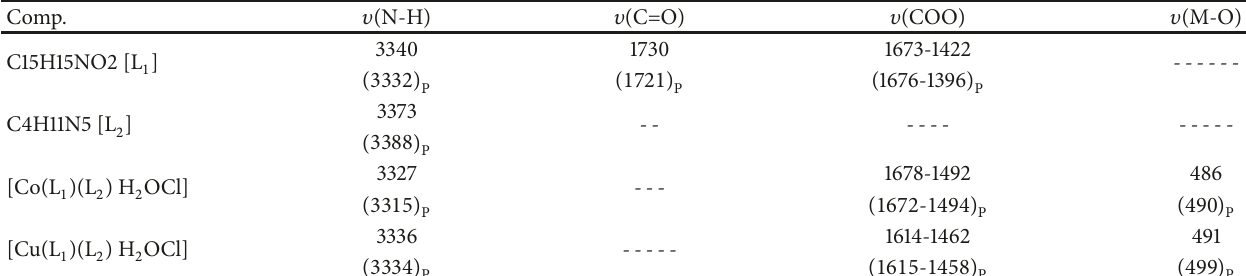
Table 2: Experimental and theoretical IR spectrum bands of ligands and their complexes.